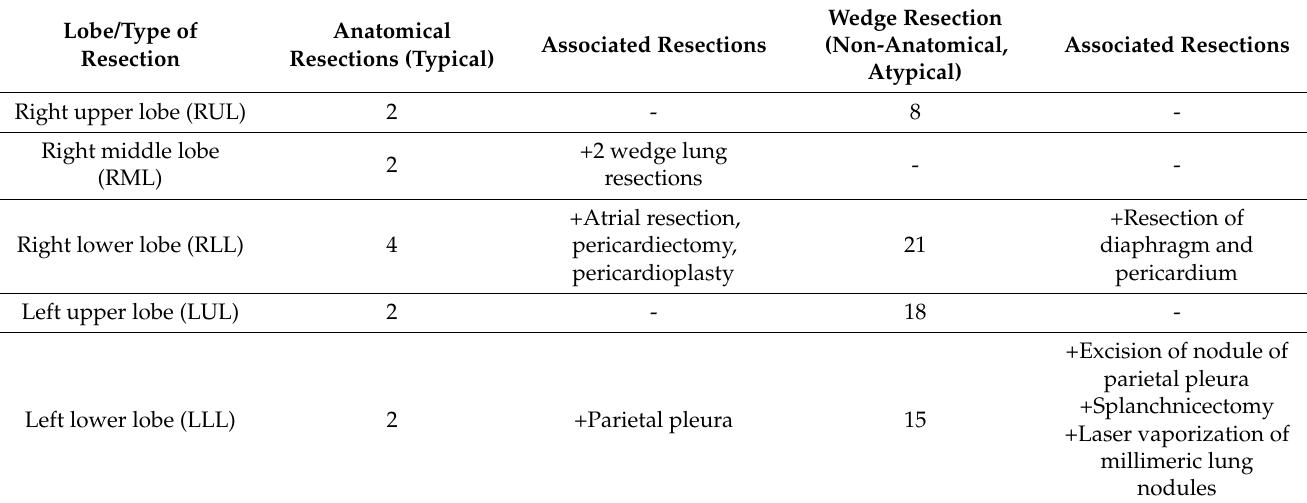
Table 2. Type of surgical resection of the pulmonary metastases and the associated structures excised for radical surgery.